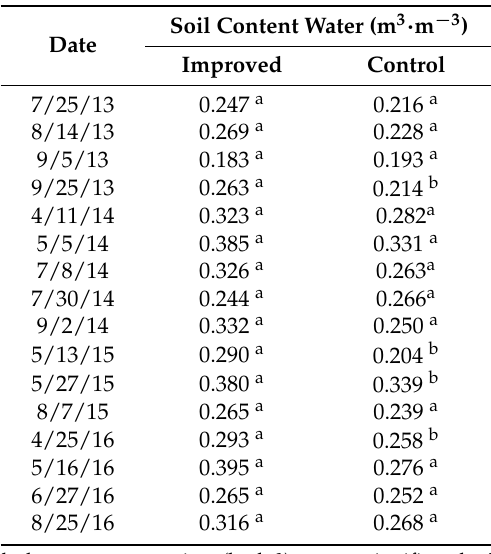
Table 1. Comparison 1 of surface water (0–6 cm) for improved and control